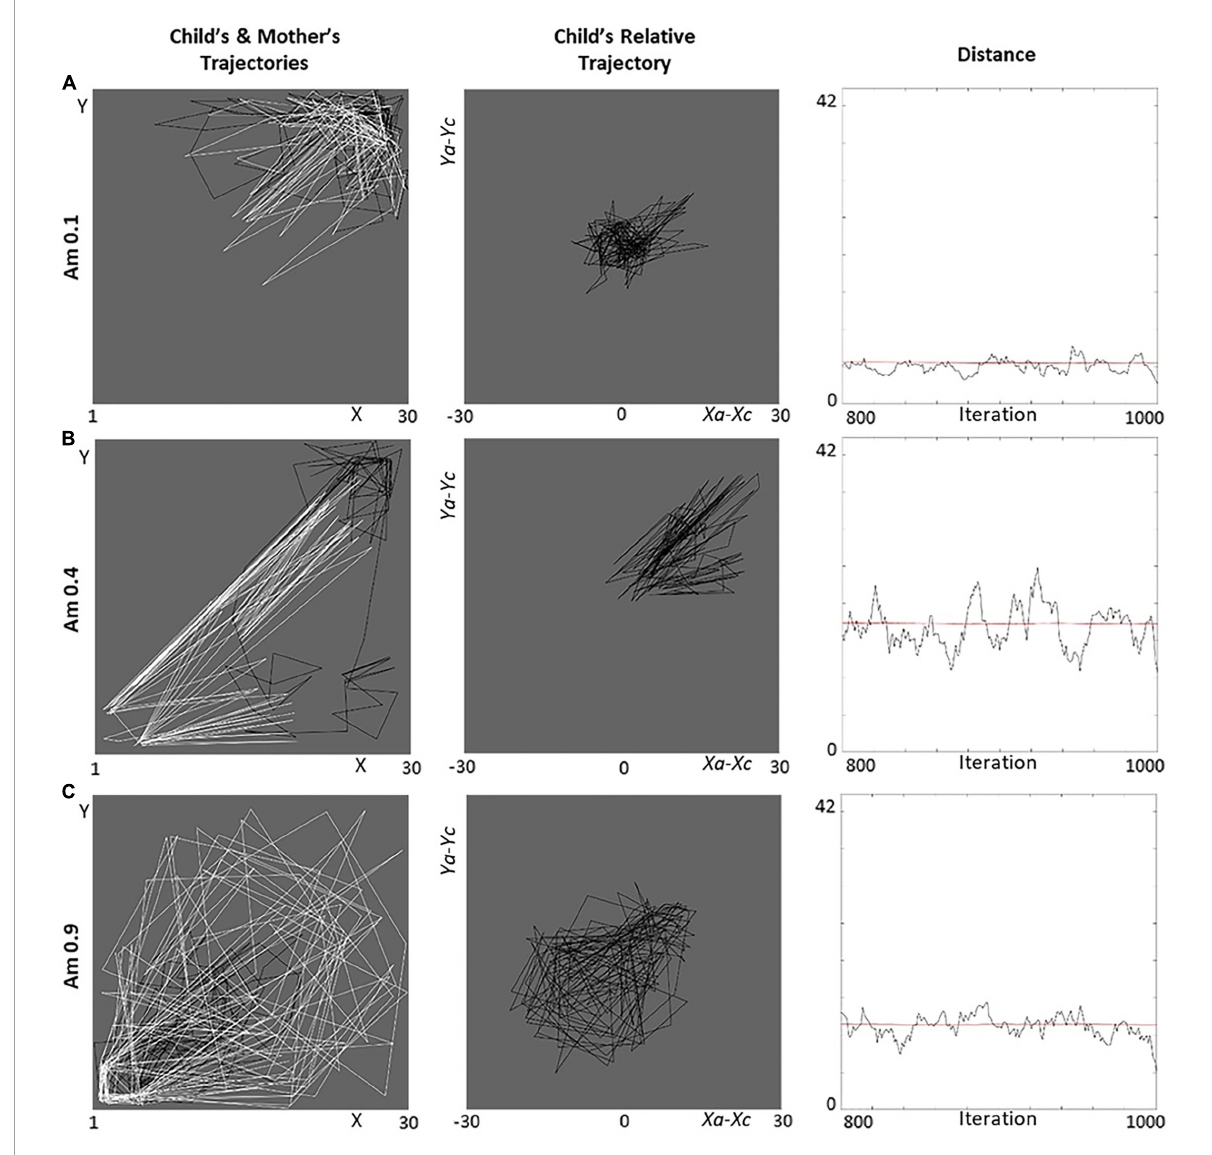
FIGURE9 Behavior of ambivalent dyads for different dimensional levels. Three ambivalent levels represent the (A) ‘anti-ambivalent’ ( A m = 0 . 1), (B) secure ( A m = 0 . 4), and (C) (extremely) ambivalent ( A m = 0 . 9) cases in terms of the agents’ trajectories (black for the child, white for the mother), child’s trajectory relative to mother, and distances (smoothed with a moving filter). In the left-column pictures, the objects of interest for child and mother are located in the top-right and bottom-left corners, respectively. All graphs refer to iterations 800–1,000 (the last 200 of our